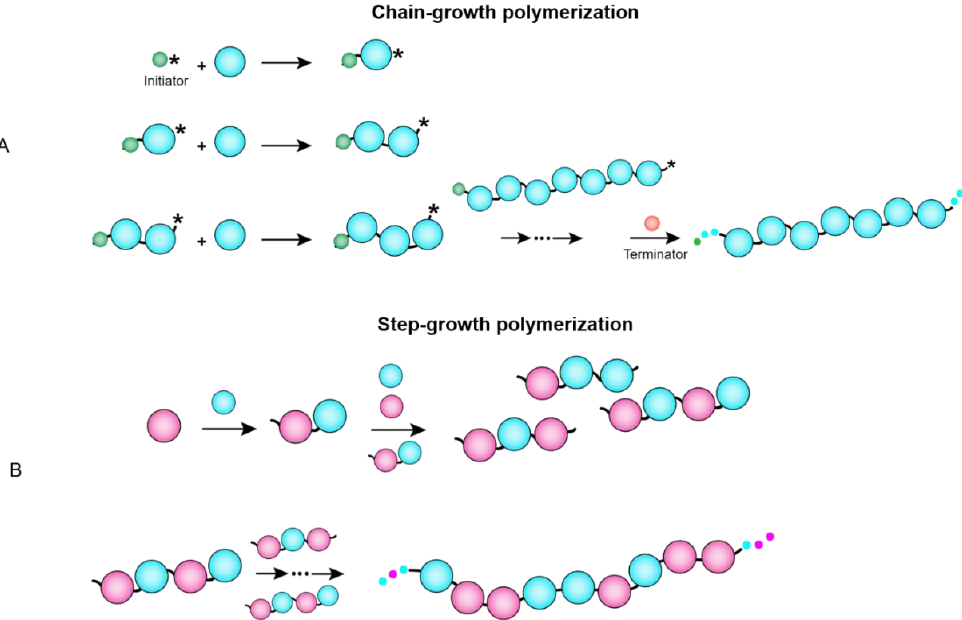
Figure 2. Random copolymerization of building blocks (cyan and pink circles) ( A ) via random chain growth and ( B ) step growth polymerization mechanisms. Asterisks represent the radical atoms. Initiator and terminator are, respectively, shown as in green and red.